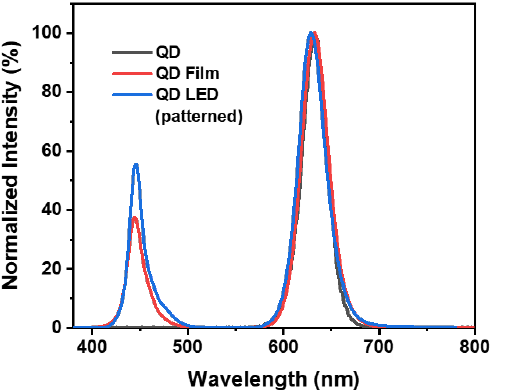
Figure 6. PL spectra of pristine QD (solution), QD film, and QD pattern excited by a 445 nm LED light source. Table 3. Thickness and optical performance of QD, QD film and QD pattern.